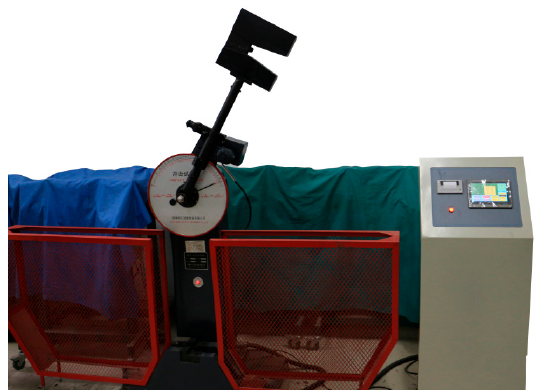
Figure 2. Charpy impact testing machine with a hammer having pre-lift angle of 150°. The samples were obtained in directions both parallel to the deposition (hereafter referred to as horizontal) and perpendicular to the deposition (hereafter referred to as vertical). Due to the